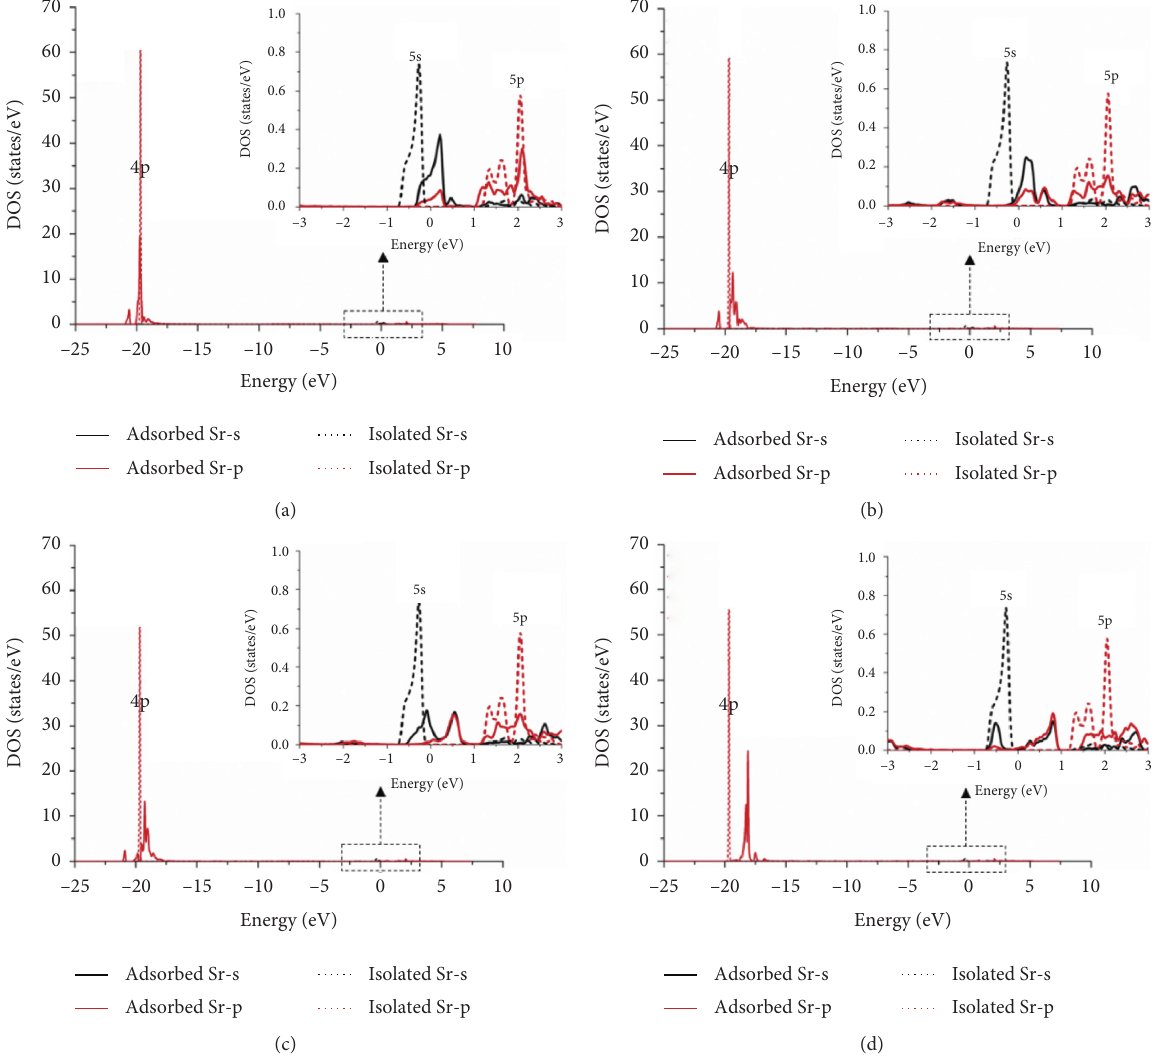
Figure 11: The DOS for isolated Sr atom (dashed line) and Sr adsorbed on matrix graphite surface (solid line): (a) perfect matrix graphite surface; (b) “bridge” interstitial defect; (c) “spiro” interstitial defect; (d) single vacancy defect. The energy is relative to Fermi level ( E f ) at E �